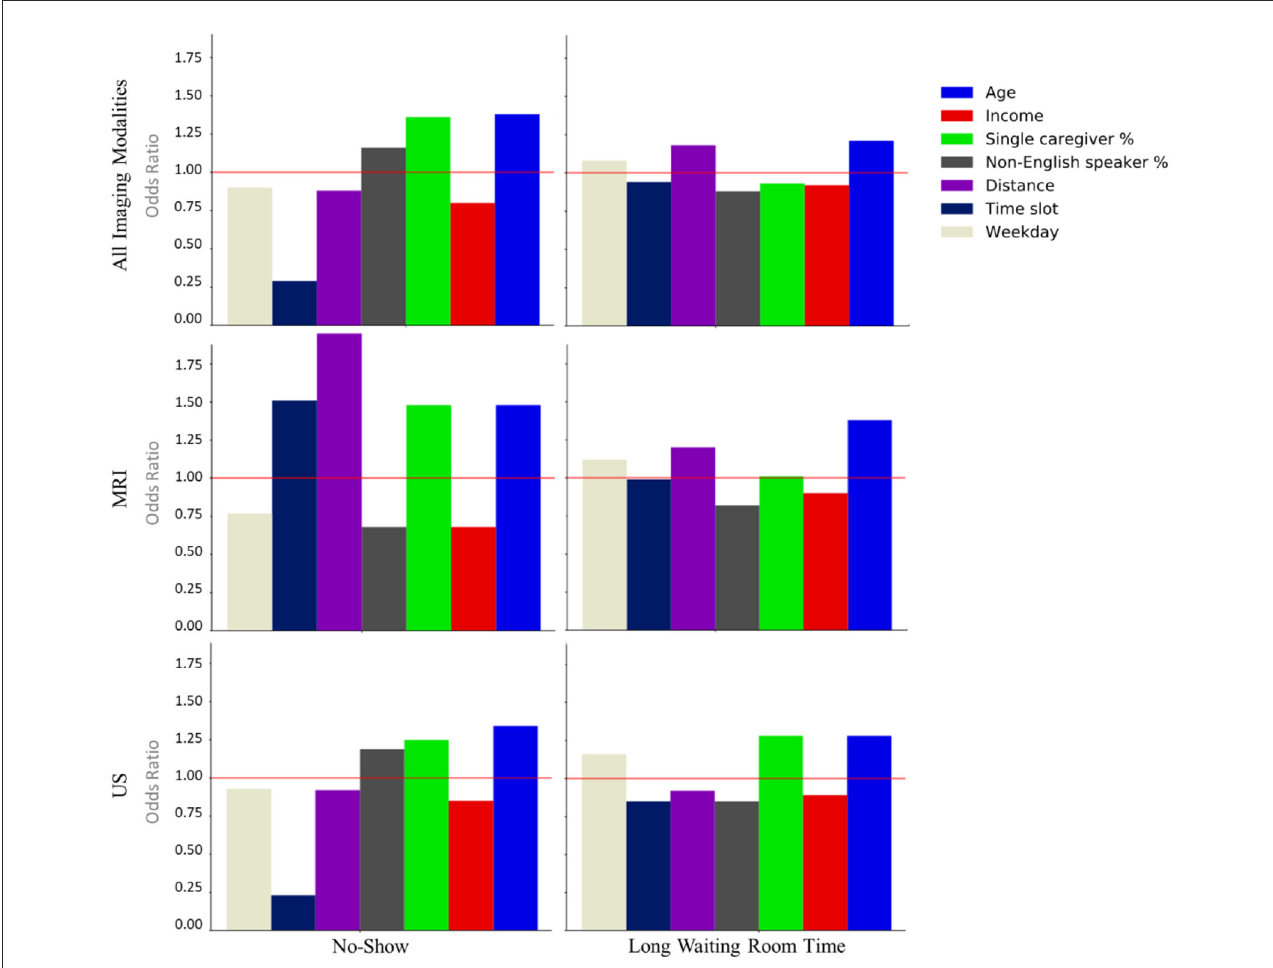
FIGURE2 Odds ratios of the statistically significant features ( p < 0.05) associated with the no-show and long waiting room time